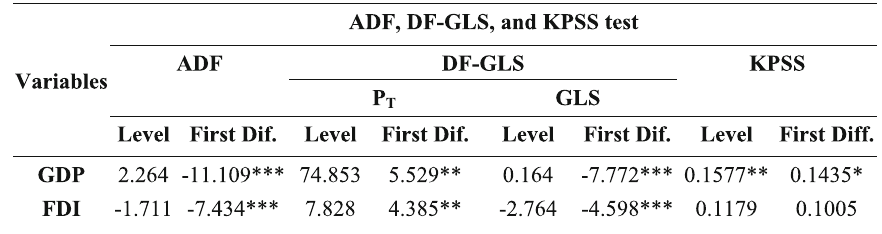
Table 2 Results of unit root